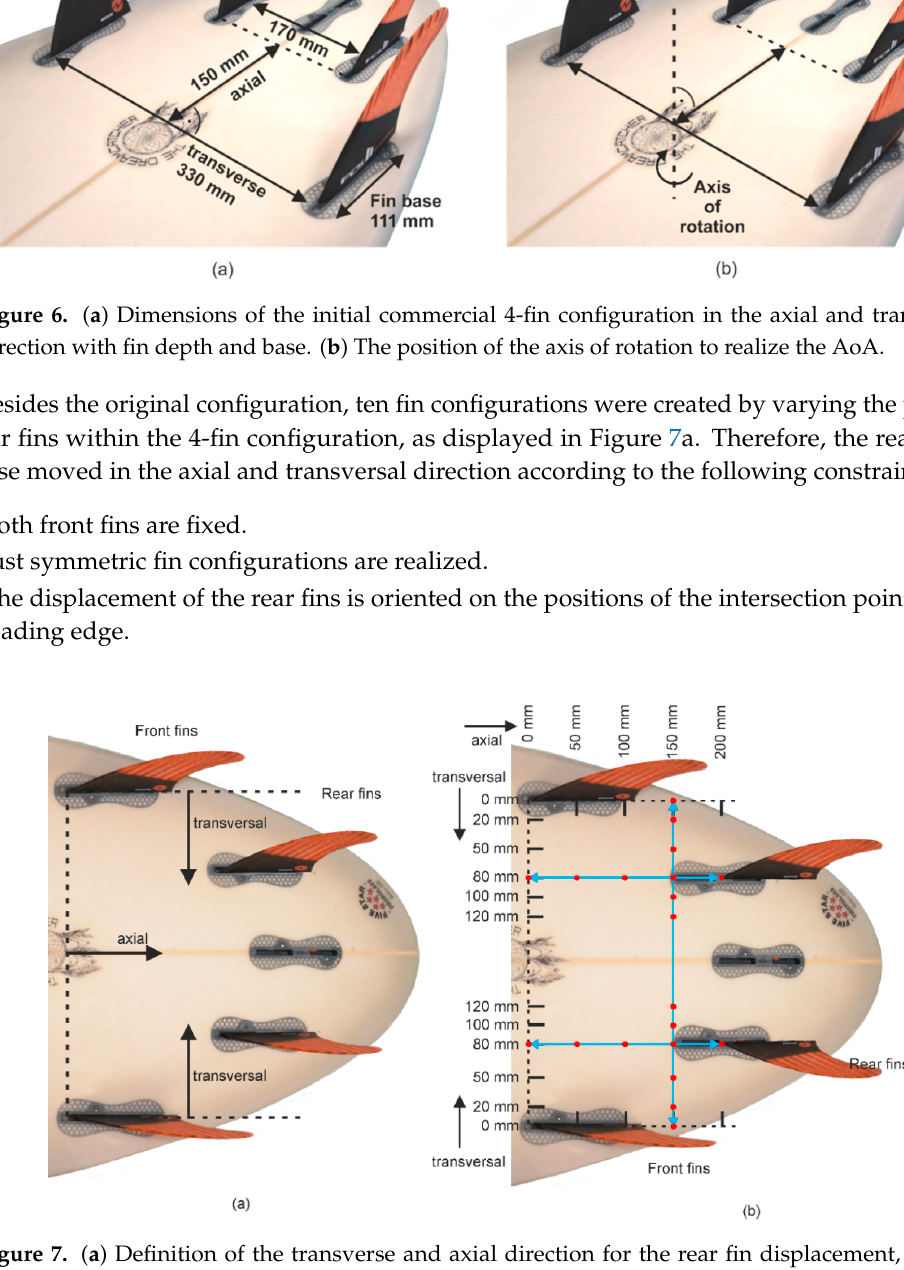
Figure 7. ( a ) Definition of the transverse and axial direction for the rear fin displacement, ( b ) ten positions of the rear fins for each side (inside fins/outside fins (IF/OF)) marked with red dots. The figure represents the configuration with rear fins positioned at a transversal position of 80 mm and an axial position of 200 mm (T:80 A:200).